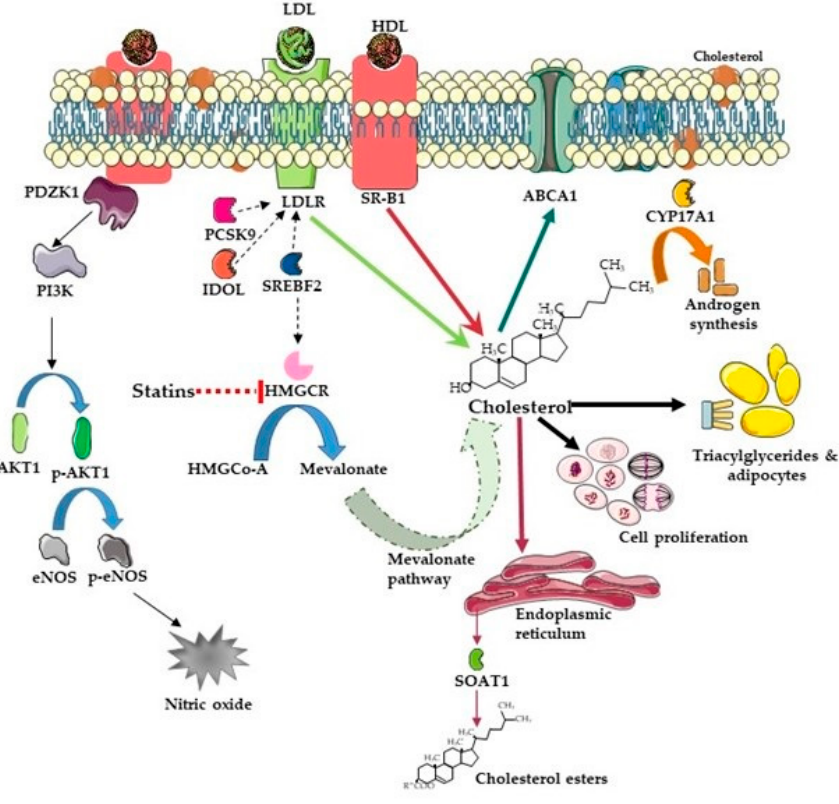
Figure 3. Cholesterol–intracellular and intratumoral metabolism. Cellular uptake of cholesterol is mediated by endocytosis of low density lipoproteins (LDL) via the LDL receptors (LDLRs), and partially trough HDL receptors (HDLRs), ore commonly known as scavenger receptor, Class B1 (SR-B1). LDLR levels in cells is tightly regulated by proprotein convertase subtilisin/kexin type 9 (PCSK9) and inducible degrader of LDLRs (IDOL). In endothelial cells, HDL is a chemotactic factor and signaling is mediated SR-B1 which is associated with (PDZ Domain Containing 1 (PDZK1)